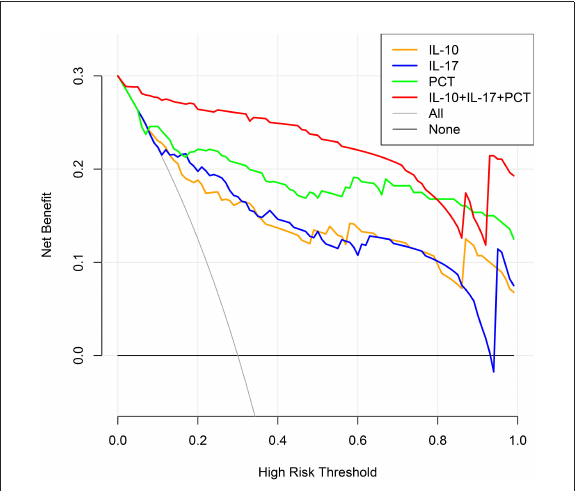
FIGURE7 Clinical decision-making curves for the development of sepsis in infected individuals were analyzed (X: probability with value, Y: net benefit, Black line: hypothesis of no sepsis in all patients, Gray line: hypothesis of sepsis in all patients).